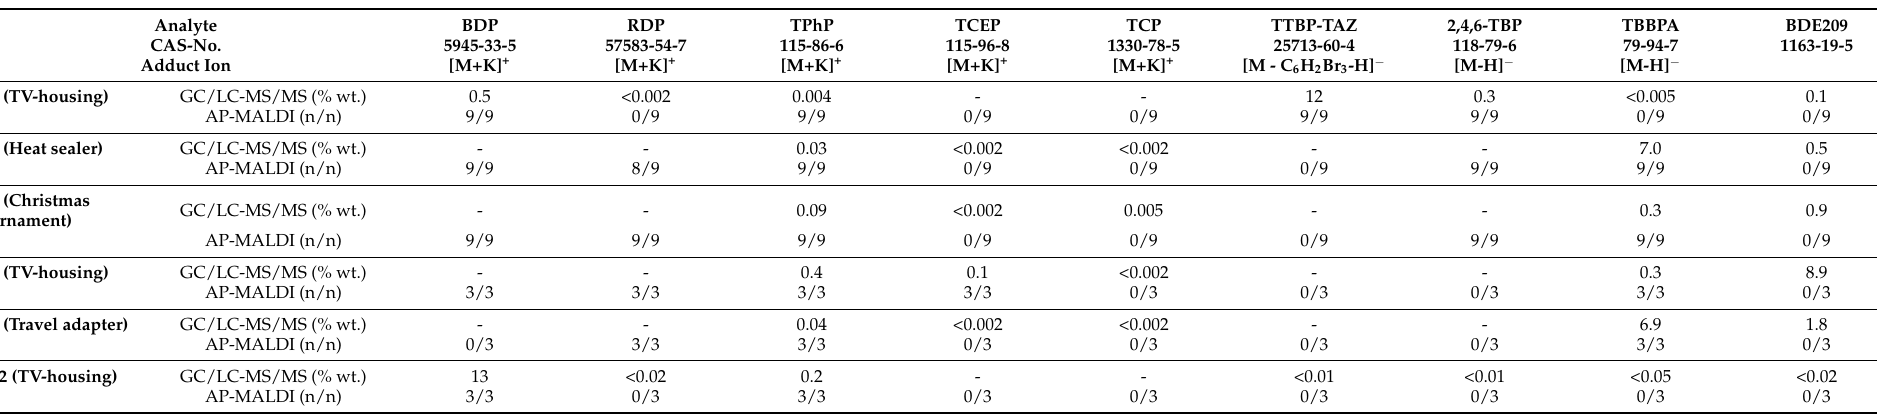
Table 2. The results of the seven plastic products analyzed with the AP-MALDI-qTOF-MS. Shown in times detected per times measured (n/3 or n/9). The OPFR and BFR concentrations given in wt.% show in this table are from previous work [48,49]. - = Not